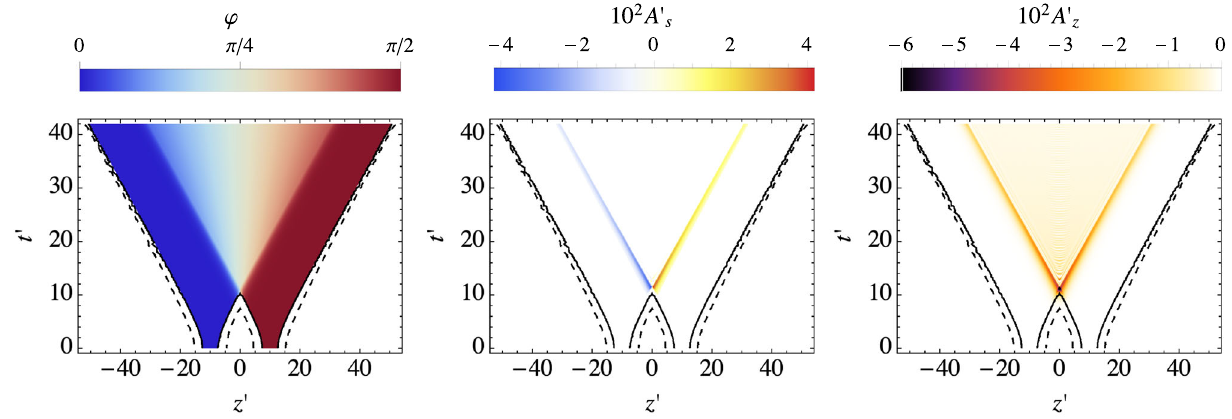
complex phase of the scalar field, in the middle panel the s component of the gauge field and in the right panel the z component of the gauge